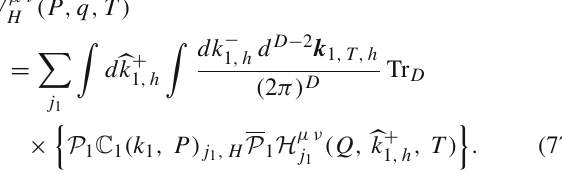
Fig. 5 a Leading momentum regions for the hadronic tensor W they appear in the first step of factorization. b Actual representation of the leading momentum regions of the hadronic tensor W